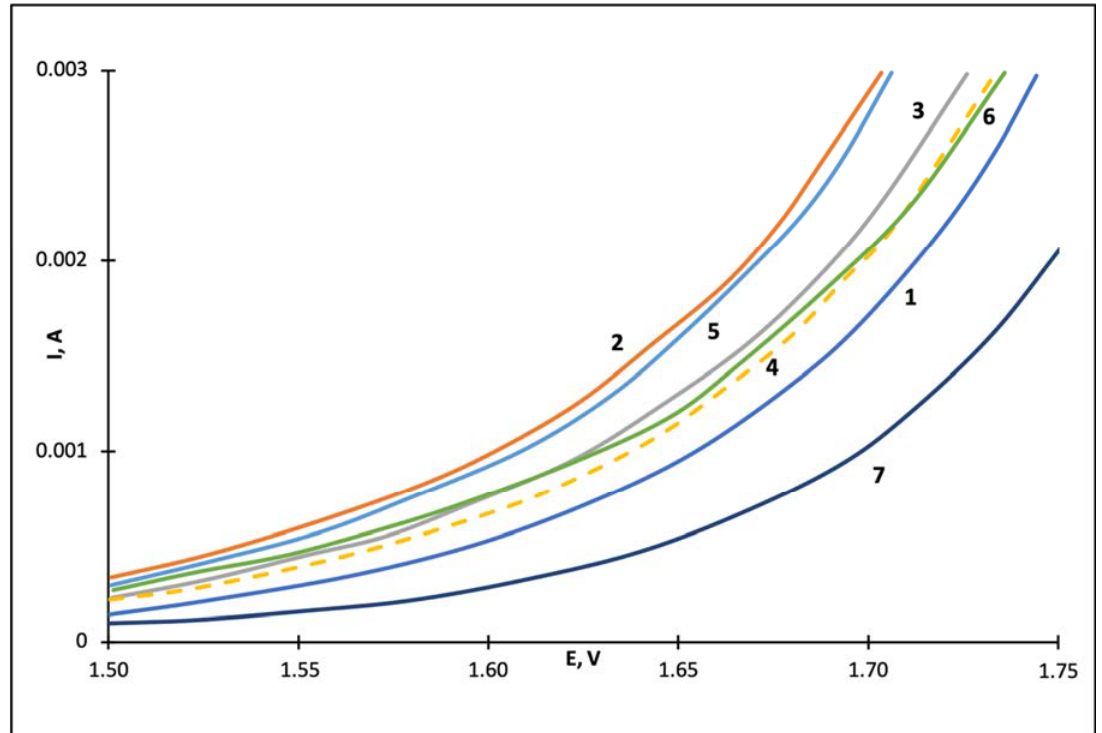
Figure 9. Polarization curves for smooth titanium electrodes with different films recorded in aqueous solution of 1M of sulfuric acid in the potential region from 1.50 V to +1.75 V at temperature of 25 °C (scan rate 0.1 mV/s). Curve 1—Pt ‐ C film obtained in the regime of PMS 10 kHz. Curve 2—Pt ‐ C film obtained in the regime of PMS 100 kHz. Curve 3—Pt ‐ C film obtained in the DC regime. Curve 4—Pt film obtained in the regime of PMS 10 kHz. Curve 5—Pt film obtained in the regime of PMS 100 kHz. Curve 6—Pt film obtained in the DC regime. Curve 7—Pt foil.